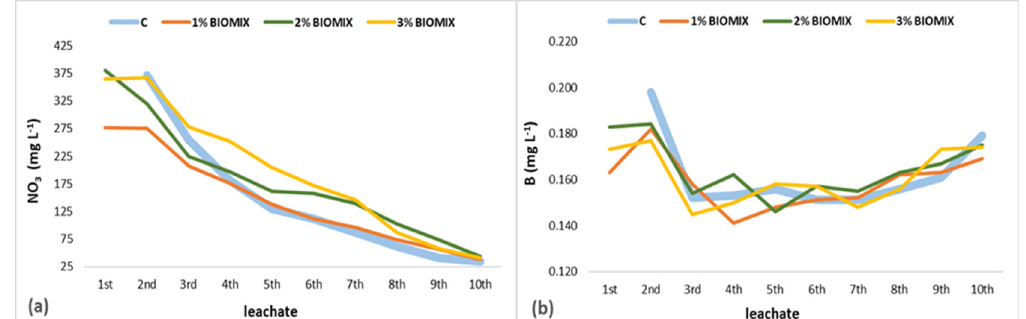
Figure 2. Changes of: ( a ) NO 3 − (mg/L) concentrations and ( b ) B (mg/L) concentrations in the leachates of the 10 irrigation applications of the four treatments. Each value is the mean of three replicates.